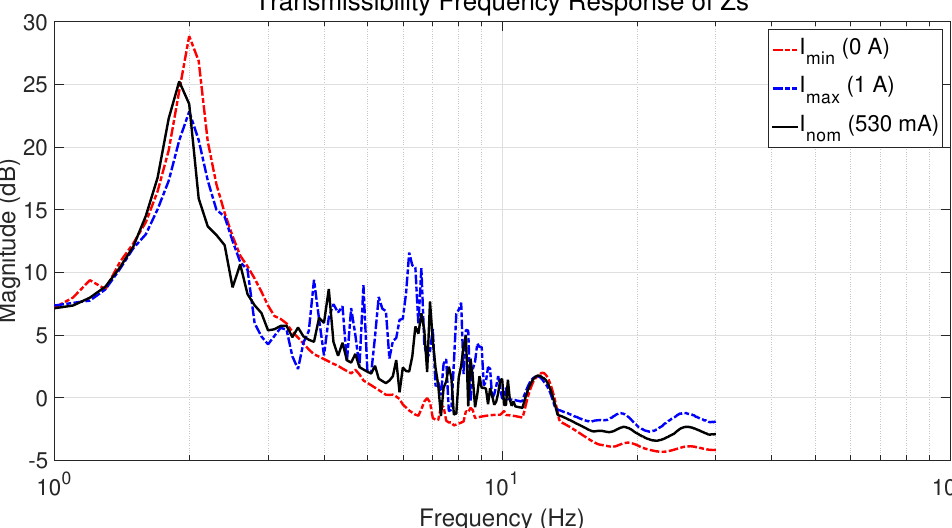
Figure 6. Comparison of Transmissibility Frequency Response (TFR) of the sprung mass displacement for different current inputs.